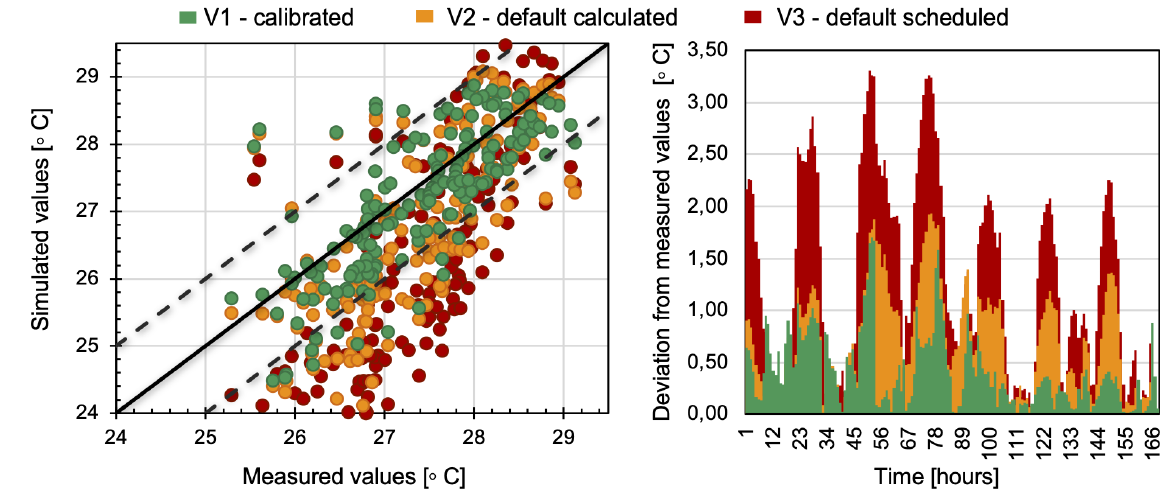
Figure 7. Results of the dynamic